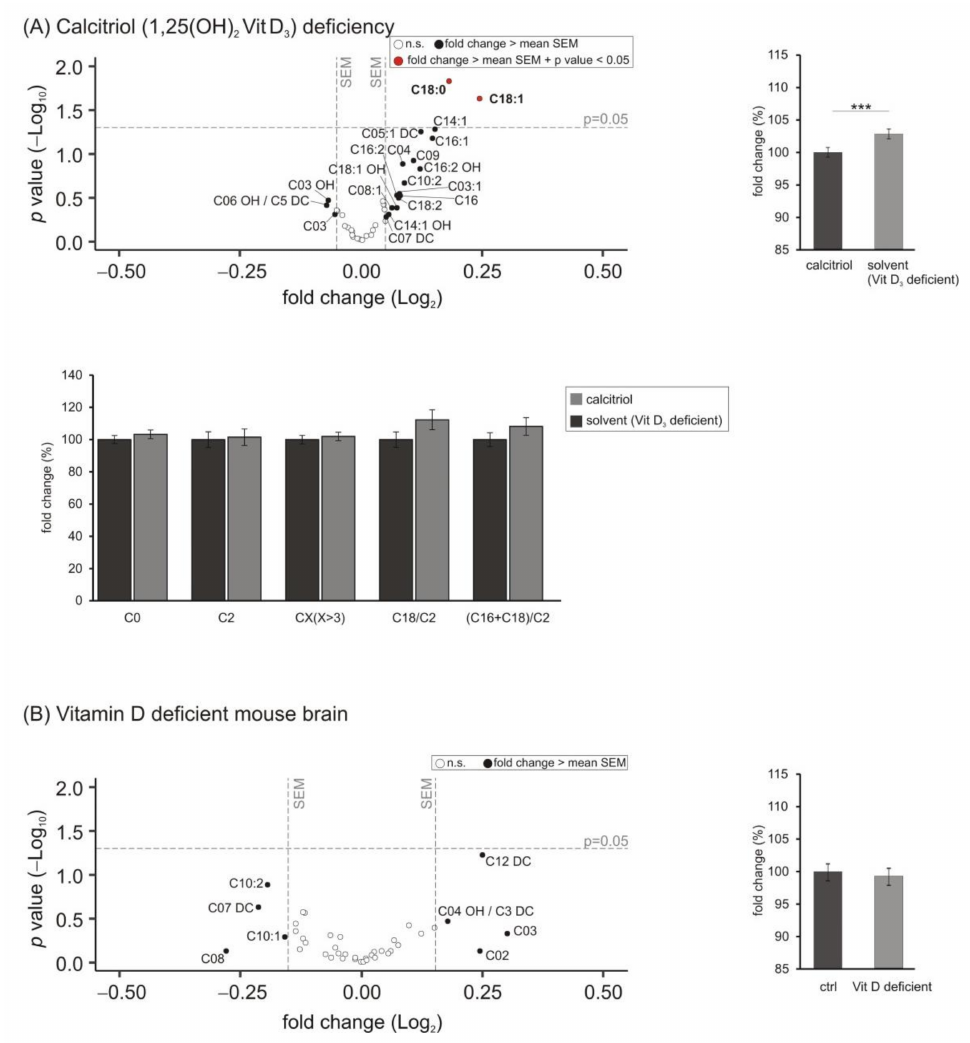
Figure 5. Effect of vitamin D 3 deficiency on carnitine species. ( A ) The levels of carnitines in SH- SY5Y wt cells incubated with the solvent control (ethanol) were compared to cells treated with 1,25-dihydroxy vitamin D 3 . In the volcano plot, the fold change ( x -axis) of each of the 41 analyzed carnitine species (dots) was plotted against the corresponding p -value ( y -axis). The volcano plots are structured as described in detail in the legend of Figure 1. The bar chart on the right shows the relative fold change of all measured carnitine species comparing calcitriol-treated with solvent- control-treated SH-SY5Y cells. The bar chart below the volcano plot shows the changes in C0, C2, CX (with X > 3), C18/C2- and (C16 + C18)/C2 ratio in SH-SY5Y cells deficient in vitamin D 3 compared to calcitriol-treated cells. ( B ) Analyzed carnitine species in brain samples of vitamin D deficient mice compared to control-fed mice in a volcano plot and relative fold changes of all measured carnitine species in a bar chart. Error bars represent the standard error of the mean (SEM). Statistical significance was set as *** p ≤ 0.001; n.s. not